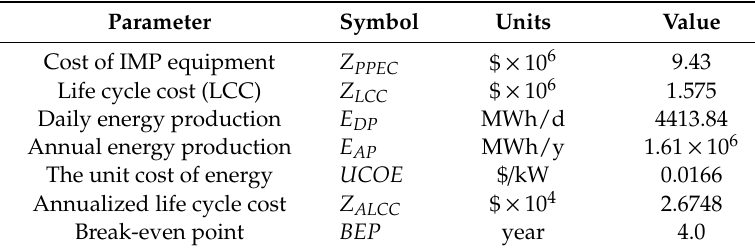
Table 12. Economic results for the IMP.